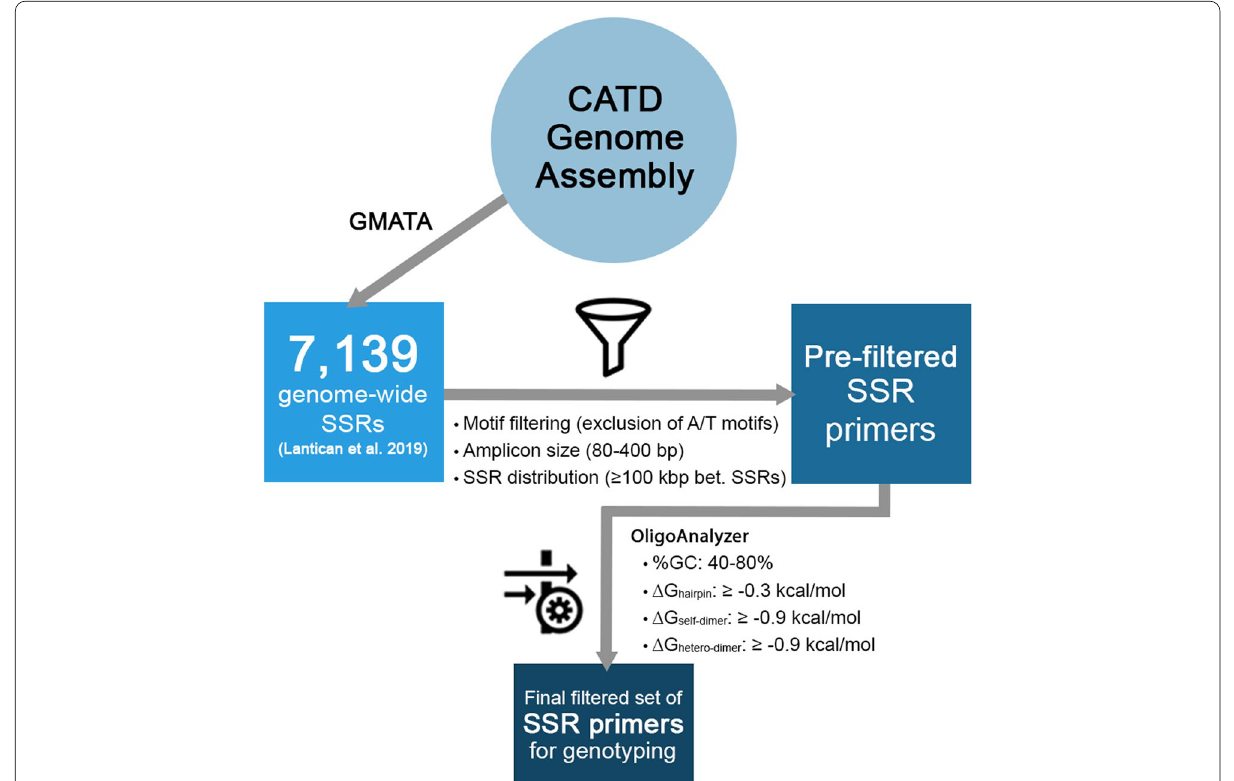
Fig. 1 Schematic diagram depicting the SSR primer filtering